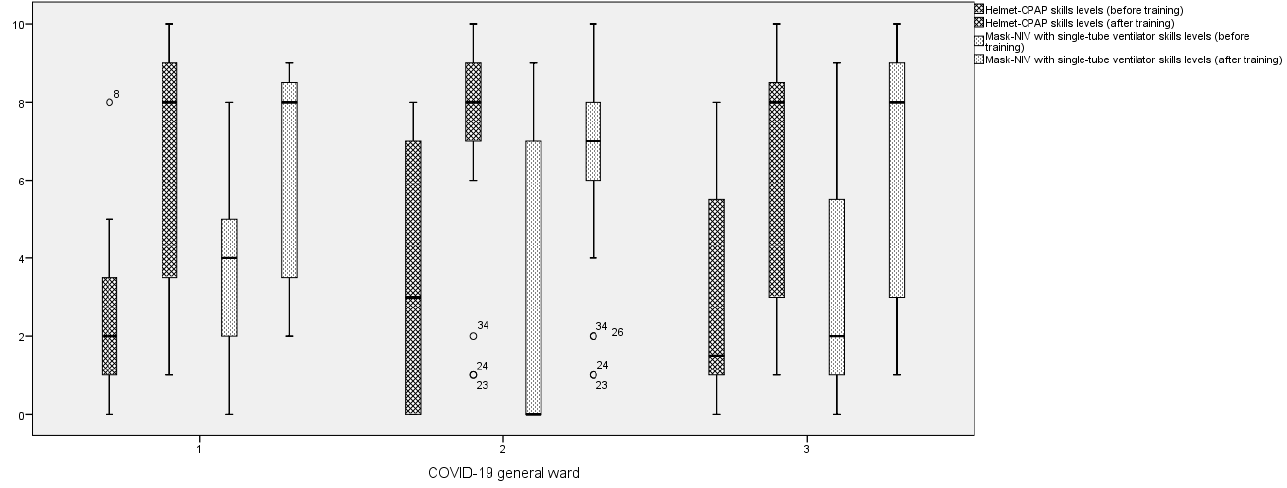
Figure 2. Comparison of Helmet-CPAP and NIV skill levels before and after the training by wards 1, 2, and 3. Table 2. Frequency of practicing the skills before and after the training on the job in the total sample (59